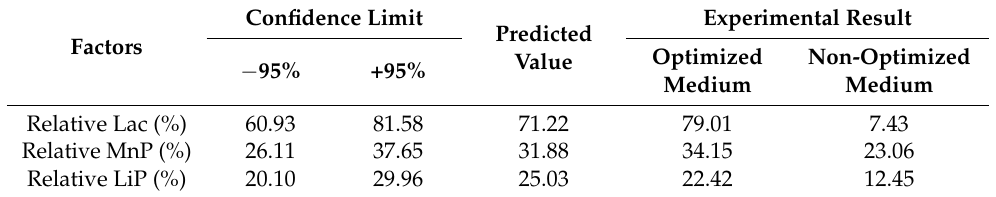
Table 3. Validation of the optimum conditions predicted for Lac, MnP and LiP relative activities.